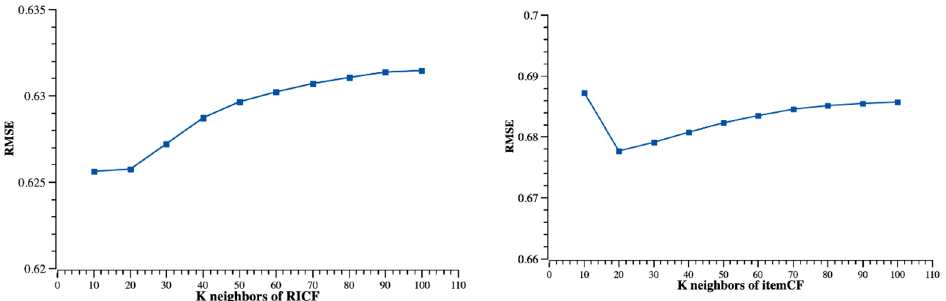
Figure 8. RMSE of K-neighbors selection on MovieTweetings-latest dataset.